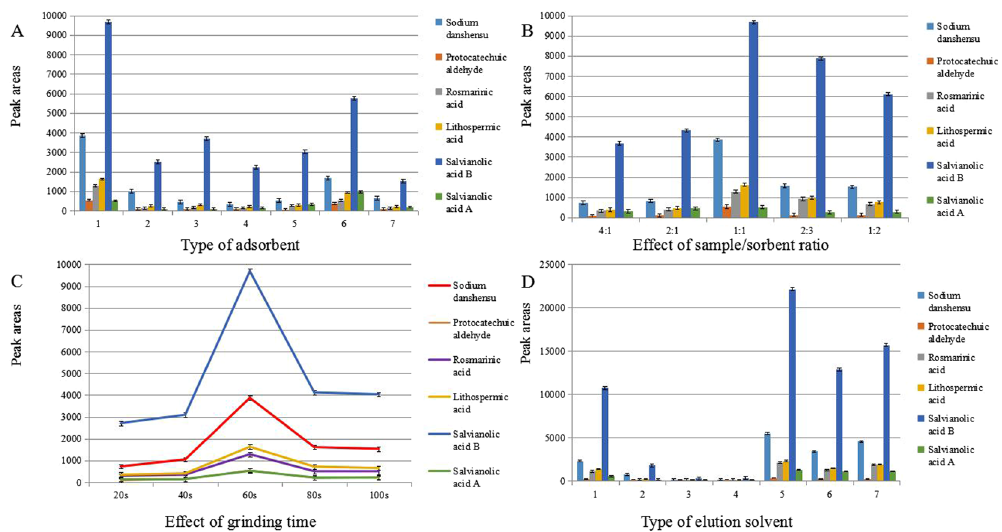
Figure 5. The optimization of MSPDM process. 24 mg of Danshen tablets were used and the volume of elution solvent was 0.2 mL. ( A ) Effect of the type of sorbent on the extraction efficiency of phenolic acids. Extraction conditions: amount of sorbent, 24 mg; grinding time, 60 s; type of elution solvent, methanol. Type of sorbent: (1) GnPs, (2) graphene, (3) graphene oxide (sheet), (4) graphene oxide (powder), (5) Al 2 O 3 , (6) C18, (7) SWNT. ( B ) Effect of sample/sorbent ratio: 4:1, 2:1, 1:1, 2:3 and 1:2. Extraction conditions: type of sorbent, graphene nanoplatelets; grinding time, 60 s; type of elution solvent, methanol. ( C ) Effect of grinding time: 20 s, 40 s, 60 s, 80 s, 100 s. Extraction conditions: type of sorbent, GnPs; amount of sorbent, 24 mg; type of elution solvent, methanol. ( D ) Effect of type of elution solvent: (1) methanol, (2) ethanol, (3) acetonitrile, (4) acetone, (5) water, (6) methanol-water (80:20, v/v), (7) methanol-water (60:40, v/v). Extraction conditions: type of sorbent, GnPs; amount of sorbent, 24 mg; grinding time, 60